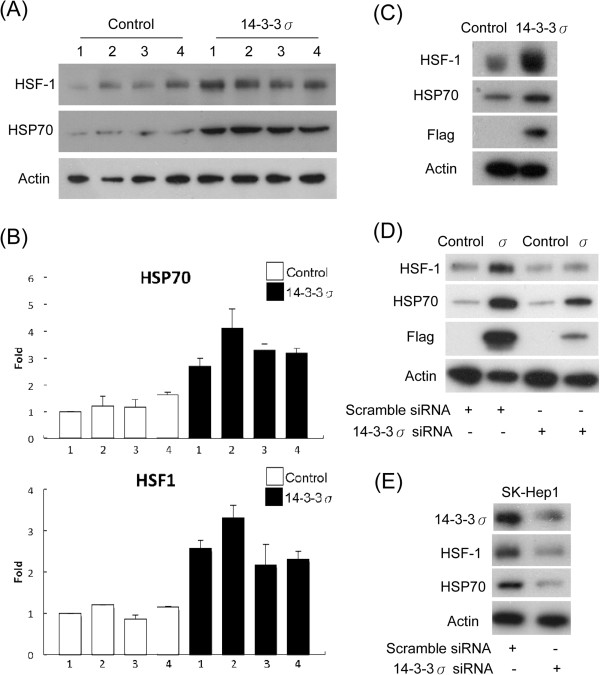
14-3-3σ induces HSF-1 and HSP70 expression. (A) Increased expression of HSF-1 and HSP70 induced by 14-3-3σ stable overexpression was determined by Western blotting and (B) real-time PCR analysis. Lanes 1–4 indicate as 4 different stable clones selected from the single colonies. Scale bars: mean ± SD. (C) Transient transfection of 14-3-3σ overexpression induced HSF-1 and HSP70 expression. (D) Knockdown of 14-3-3σ with siRNA suppressed HSF-1 and HSP70 expression in 14-3-3σ stable cells and (E) SK-Hep1 cells. Expression of HSF-1, HSP70, 14-3-3σ and Flag was determined by Western blot analysis. Actin was used as a loading control.